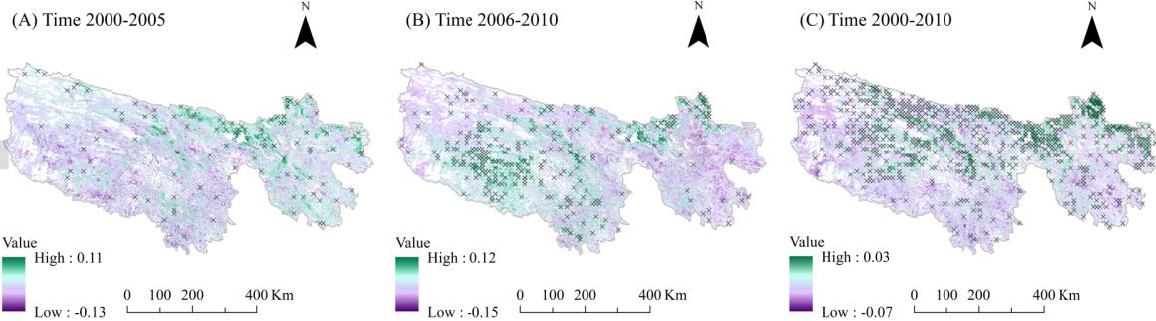
Figure 2. Spatial distribution of NDVI trends in the grassland ecosystem. ( A ) NDVI trend from 2000 to 2005; ( B ) NDVI trend from 2006 to 2010; ( C ) NDVI trend from 2000 to 2010; the fork symbol in the figure indicates the significance of NDVI trend, where p value < 0.05. (Spatial reference: Albers conical equal area; datum: D WGS 1984).